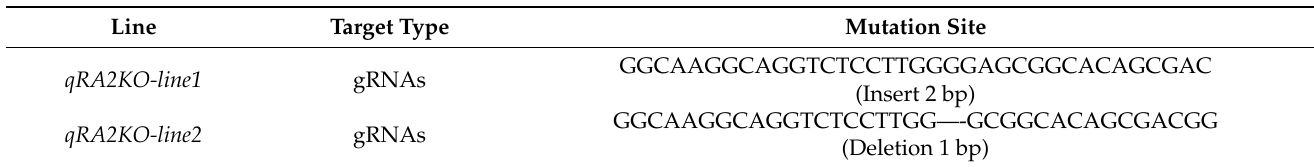
Table 4. Mutation site of three target mutant lines.